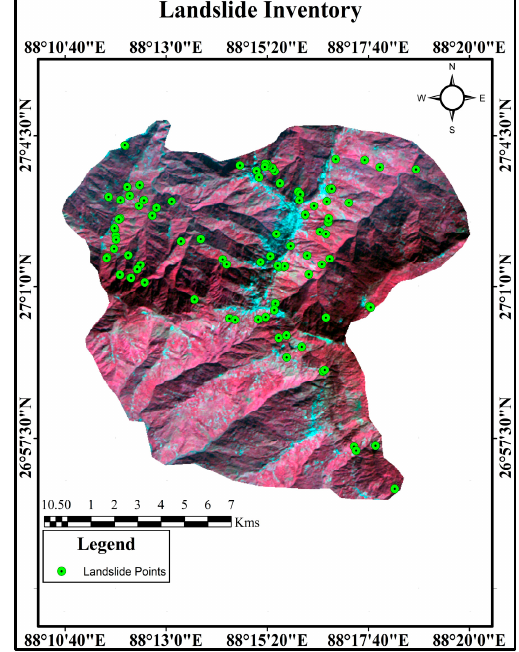
Figure 3. Map of landslide inventory of study area.